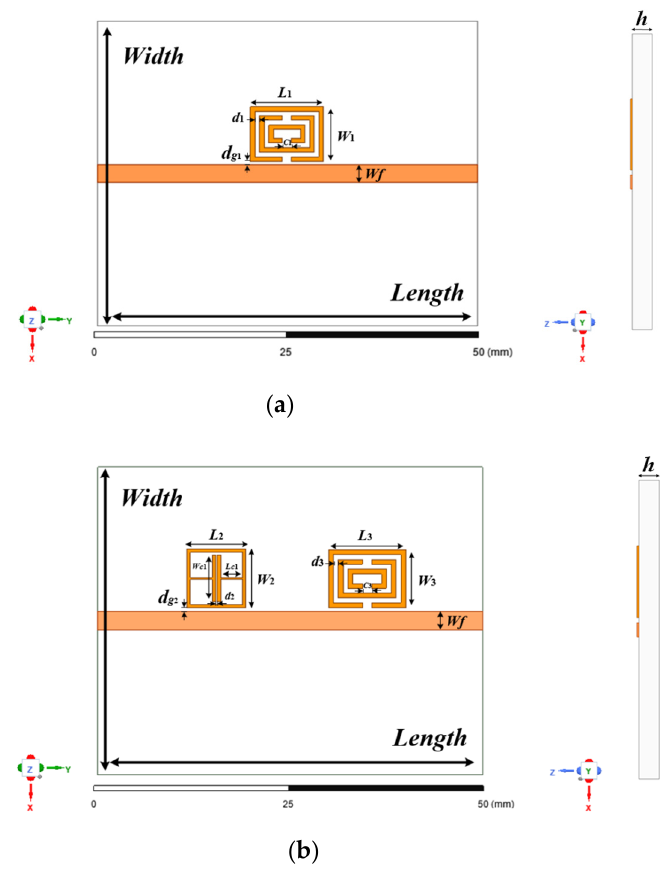
Figure 1. Chipless RFID tag design: ( a ) Microstrip-coupled CSRR resonator design; ( b ) The 2-bit RFID tag design.